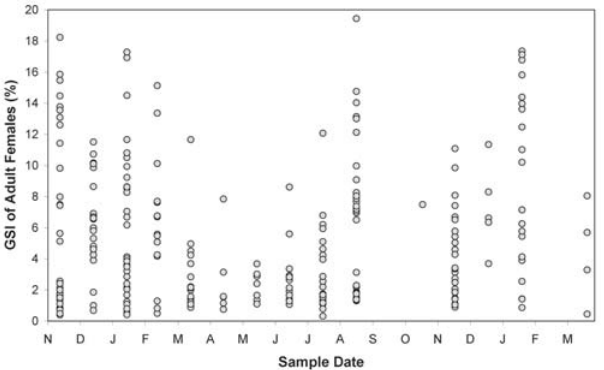
Fig. 5. Estimates of the size at first maturity (L ) as a function 50 of different cutting criteria to distinguish reproductive females Fig. 6. GSI values of adult females (larger than 11cm) of based in gonadossomatic index (GSI). Animals captured using Astyanax fasciatus captured using seine and gill nets over 17 seine and gill nets over 17 monthly samples (November/2002 monthly samples (November/2002 to May/2004) at two sites to May/2004) at two sites (lagoa do Casamento and lagoa (lagoa do Casamento and lagoa dos Gateados, Rio Grande do dos Gateados, Rio Grande do Sul State, Brazil). Sul State,